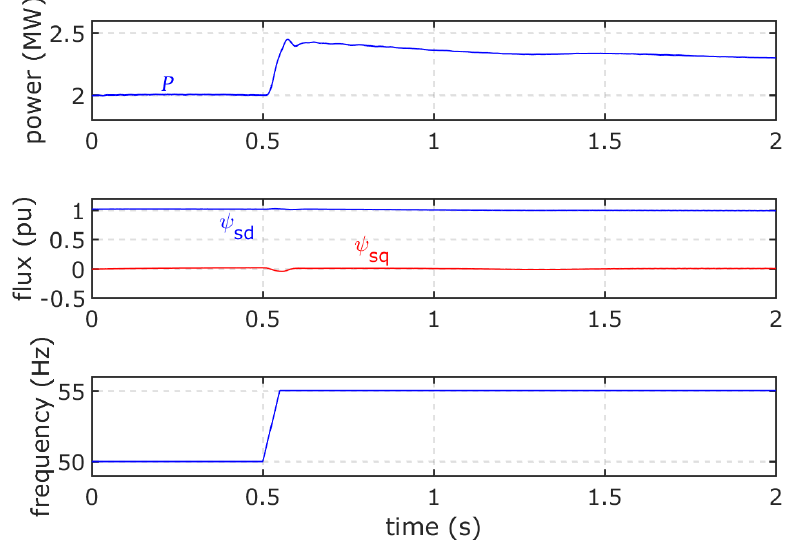
Figure 13. Response to a frequency step at constant wind speed and load. Energies 2017 , 11 , 26